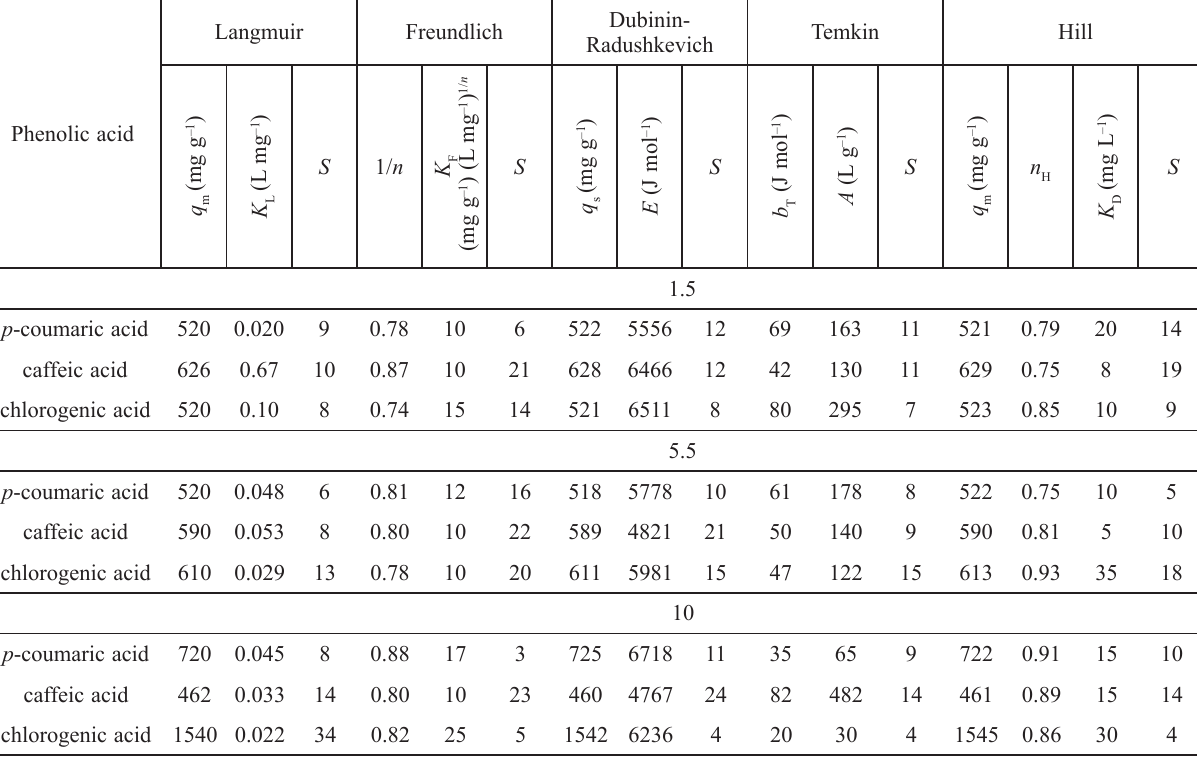
Table 3 – Apparent, theoretical, predicted parameters of Langmuir, Freundlich, Dubinin-Radushkevich, Temkin, and Hill adsorp- tion isotherms at pH values 1.5, 5.5, 10 (37